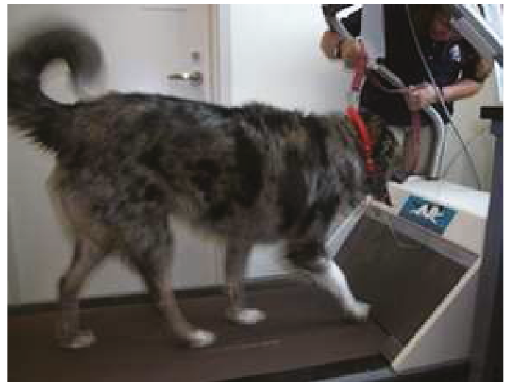
Figure 12: Pippin on the treadmill with Mary Zavanelli holding his leash and giving him encouragement.